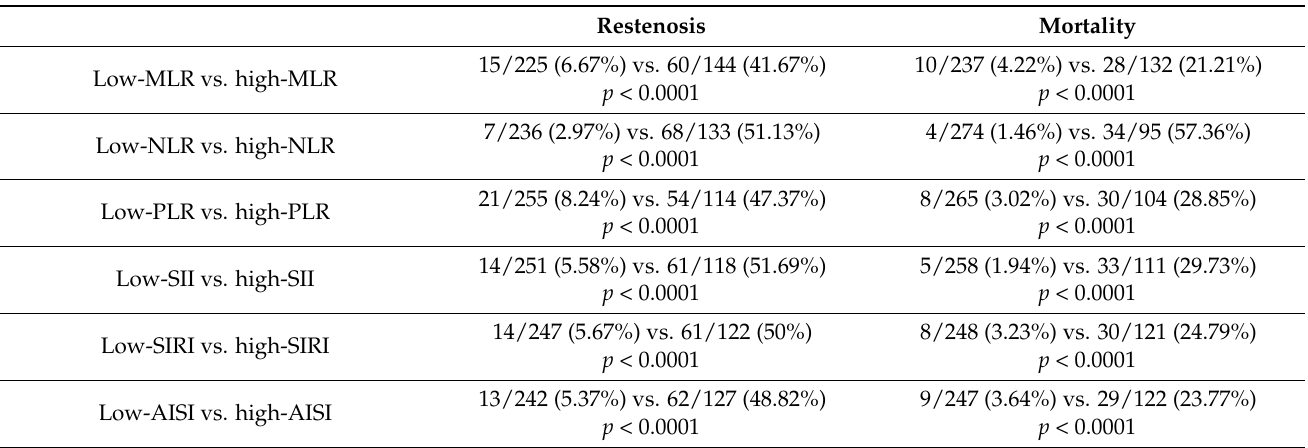
systemic inflammation response index; AISI = aggregate index of systemic inflammation.